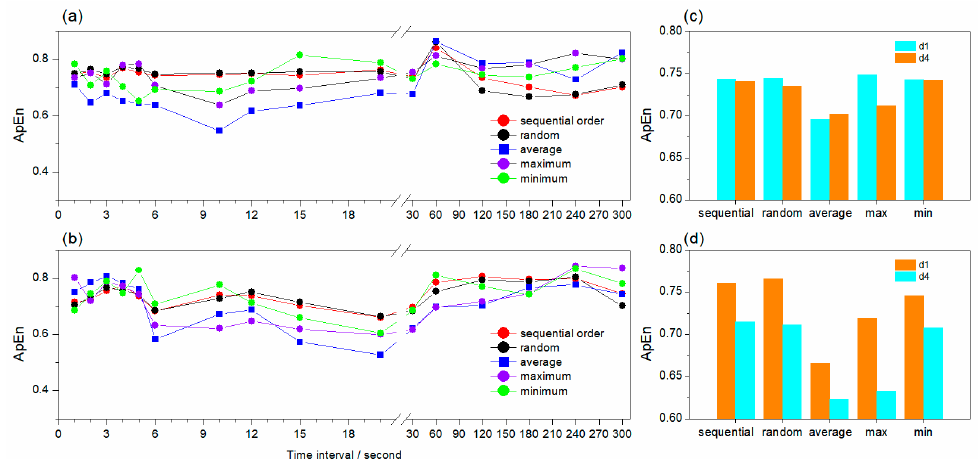
Figure 7. The ApEn values of 1 ‐ s observed wind speed obtained by the sequential order method and the random method (ten times) from 0.1 ‐ s time sequences for ( a ) d1 and ( c ) d2. The average and the box diagram of ApEn values of 1 ‐ s observed wind speed obtained by different sampling meth ‐ ods for ( b ) d1 and ( d ) d2.